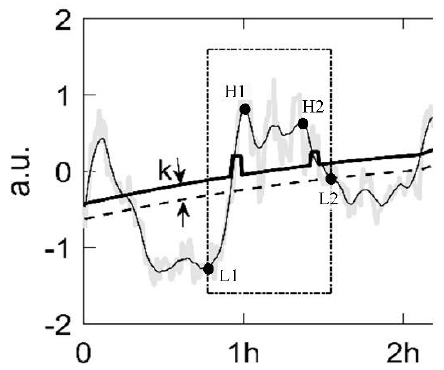
Figure 3. Graphical representation of variable threshold and window width (data are from Figure 2).